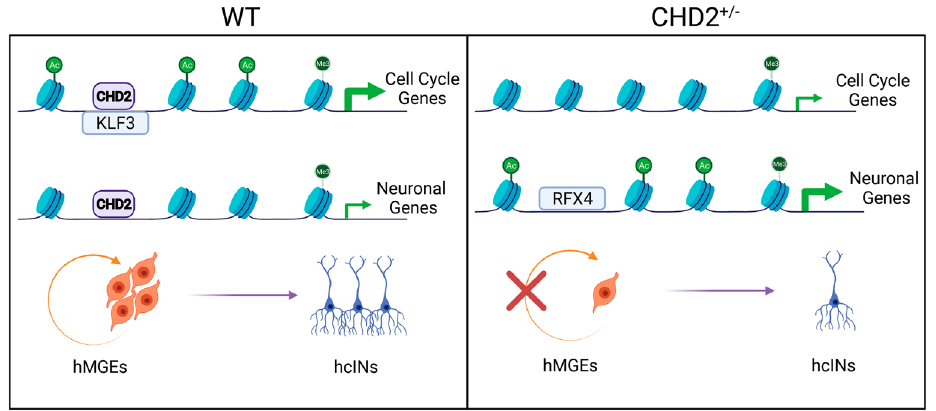
Figure 8. Model for CHD2 function during hcIN differentiation. During hcIN differentiation, CHD2 bound peaks exhibit high H3K27ac (Ac) and are near promoters enriched for H3K4me3 (Me) in genomic locations enriched for TFBS recognized by zinc finger TFs, including KLF3. CHD2-bound peaks with this configuration are associated with genes related to mitosis and cell division (cell cycle genes). Under conditions of CHD2 deficiency (CHD2 +/− ), H3K27ac is reduced at these sites and expression of the associated cell cycle-related genes is reduced. CHD2 binds another set of peaks without H3K27ac coenrichment in MGE progenitors. These are enriched for RFX TFBS and are associated with neuronal genes that are not highly expressed until hcIN differentiation. Under conditions of CHD2 deficiency, H3K27ac levels increase at these peaks and expression levels of these genes increase, potentially due to the presence of a chromatin environment permissive for binding of RFX TFs such as RFX4, which can promote neuronal gene expression. Ultimately, these direct requirements for CHD2 at two distinct direct target gene subsets results in more efficient differentiation in the CHD2 +/− model, due to consequent dysregulation of both cell cycle and neuronal